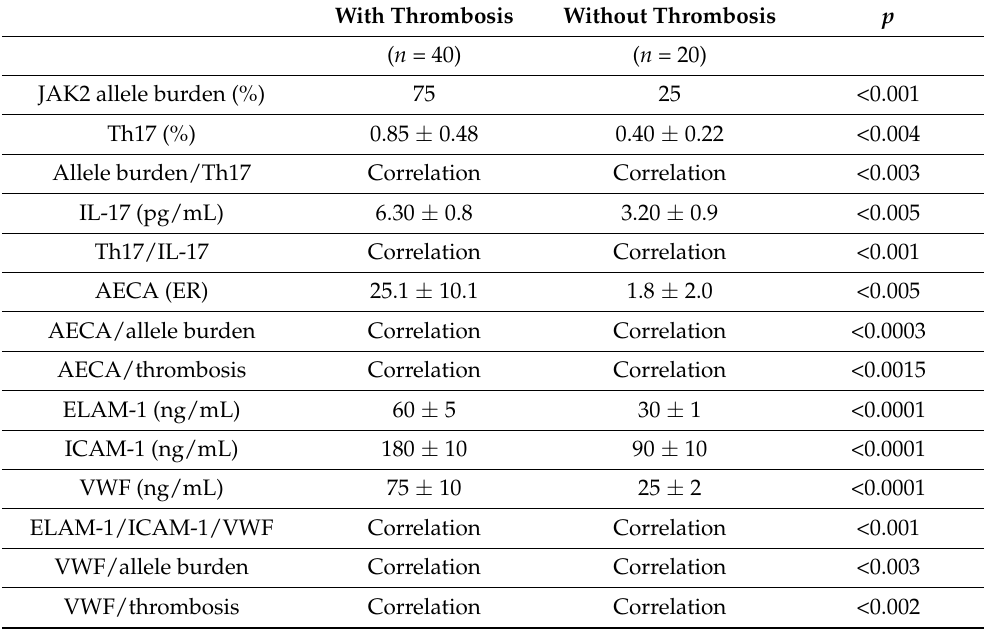
Table 3. Laboratory characteristics and statistics of the 60 PV patients. With Thrombosis